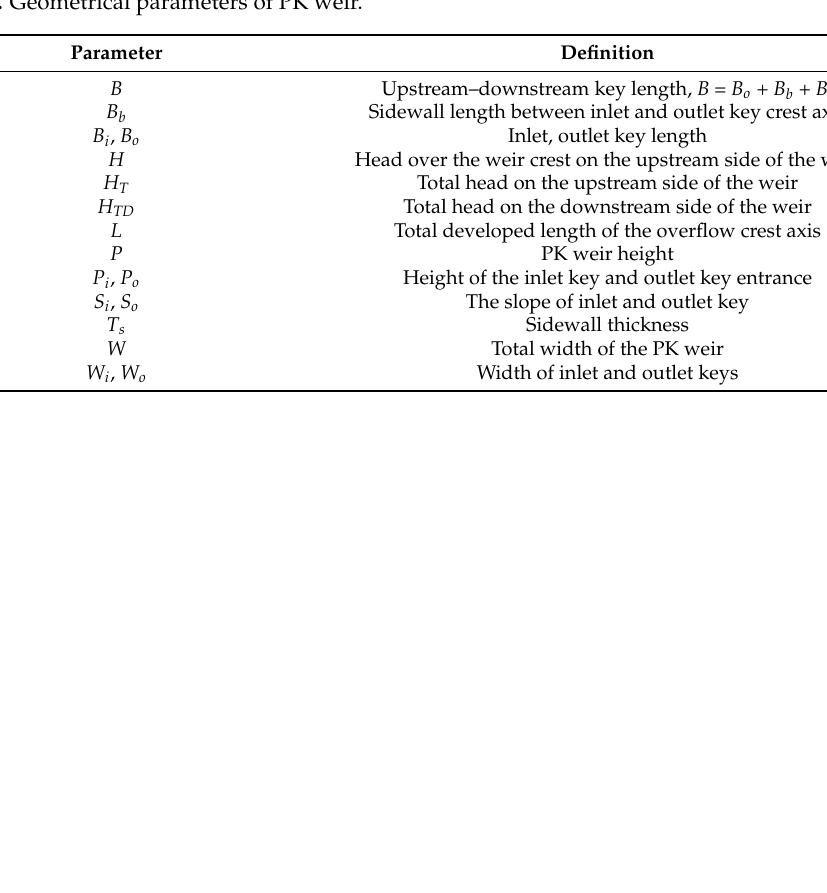
Table 1. Geometrical parameters of PK